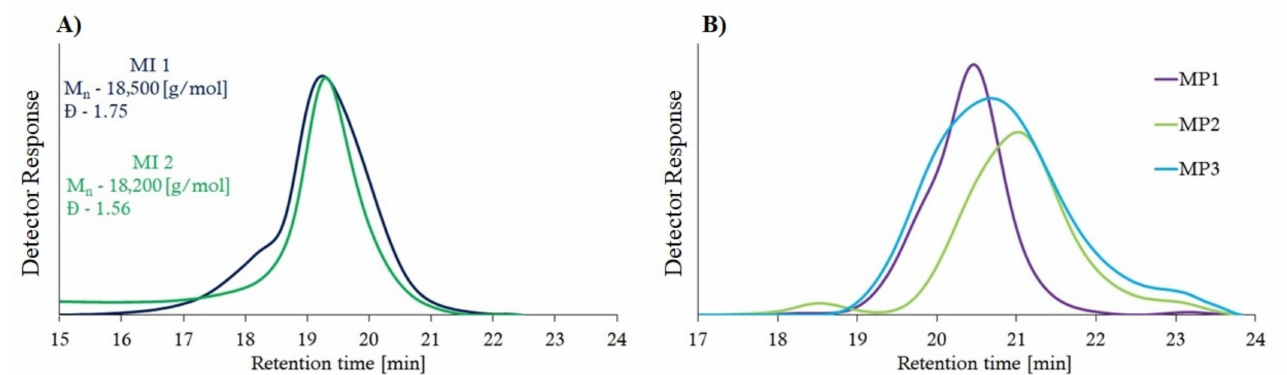
Figure 4. SEC traces of macroinitiators ( A ) and miktopolymers ( B ) before degradation.